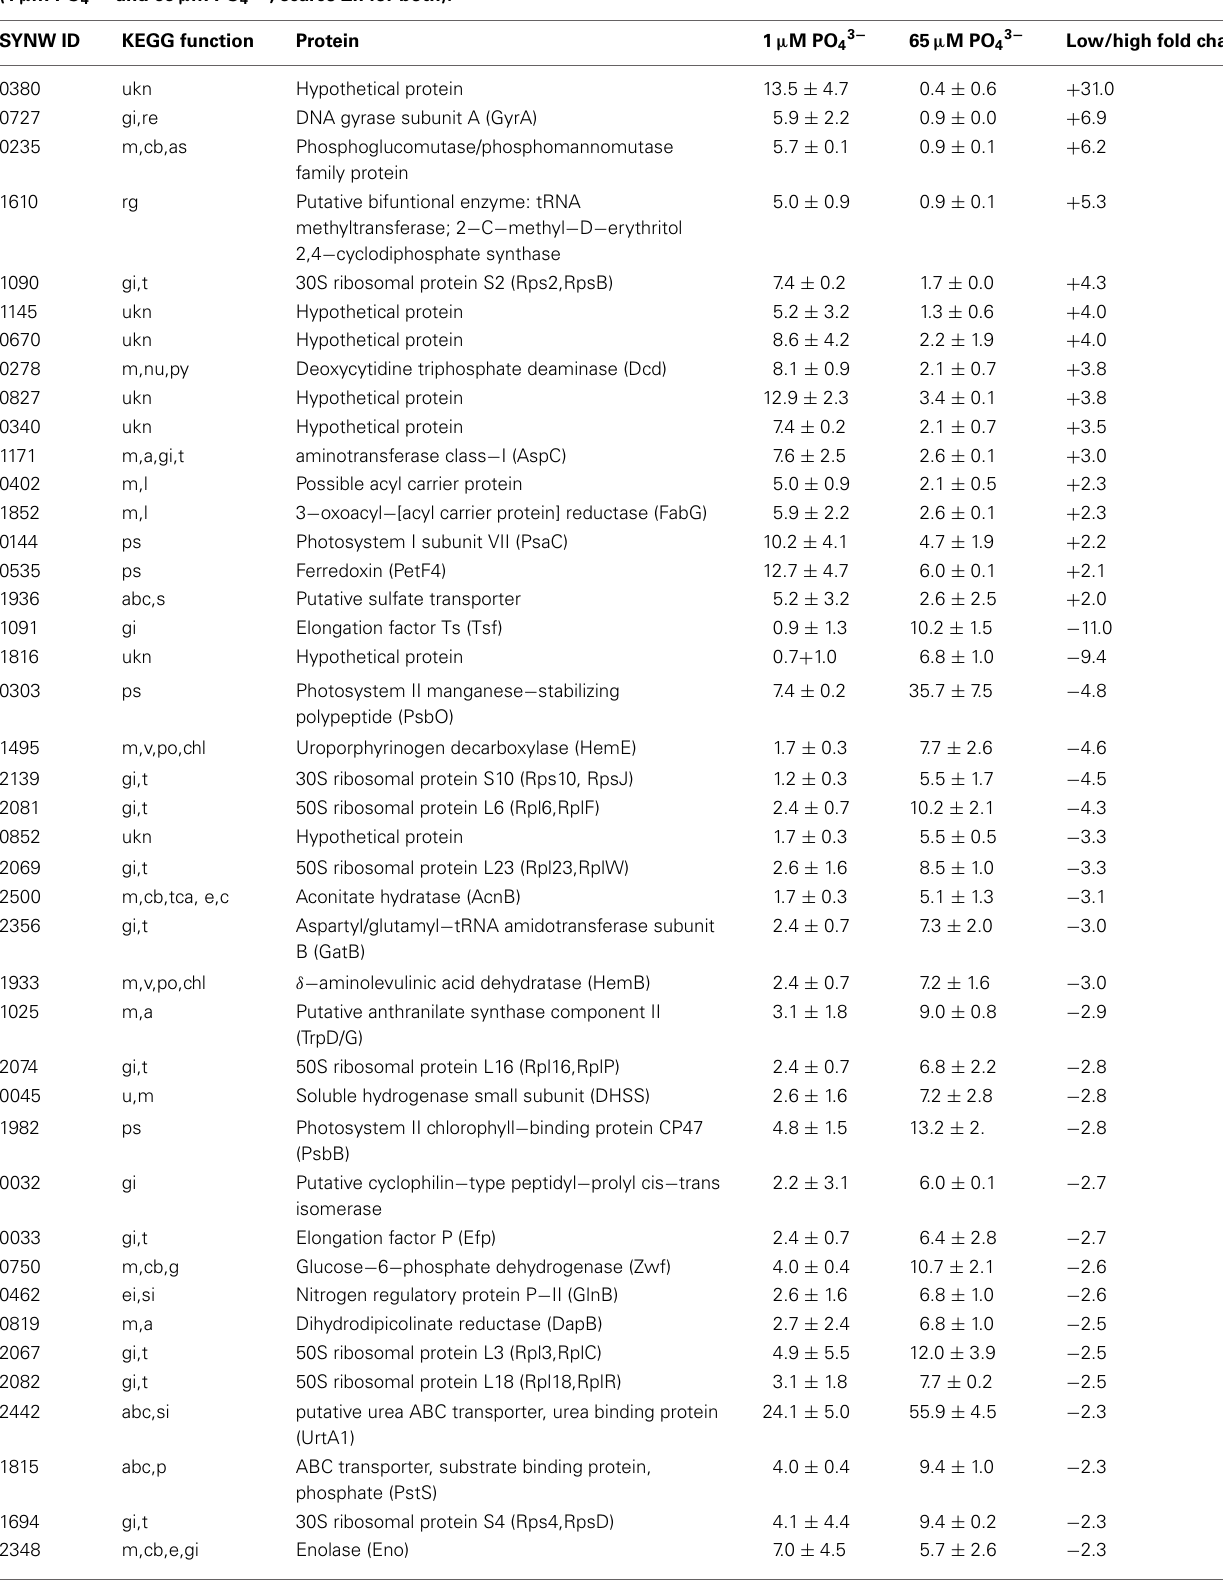
Table 2 | Relative protein abundances between low and high phosphate treatments for proteins two-fold or greater differentially abundant (1 µ M PO 43 − and 65 µ M PO 43 − , scarce Zn for